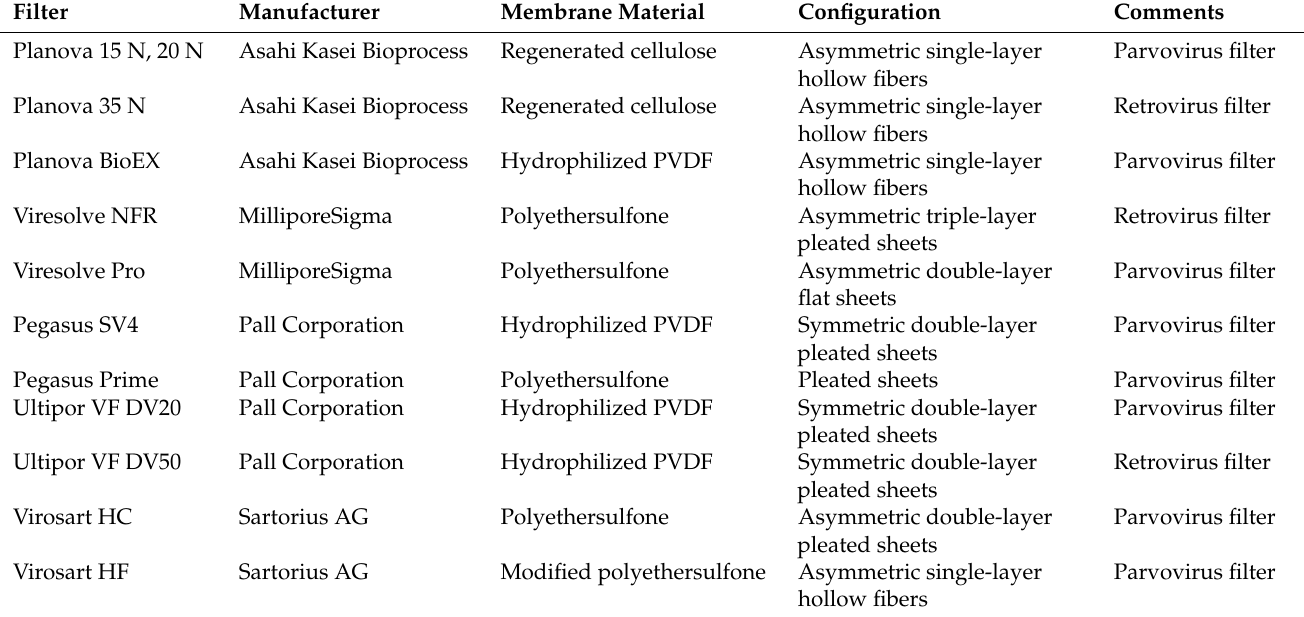
Table 3. Commercially available virus filters [2,26,27]. Asahi Kasei Bioprocess is a part of the Asahi Kasei Group; MilliporeSigma is a subsidiary of Merck